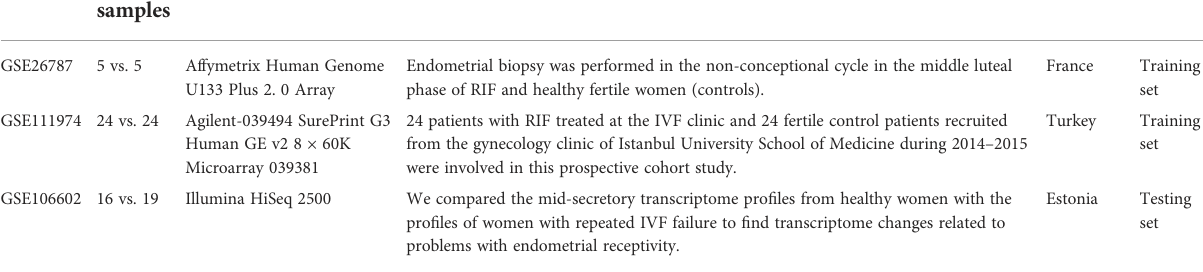
TABLE 1 Basic information of the included